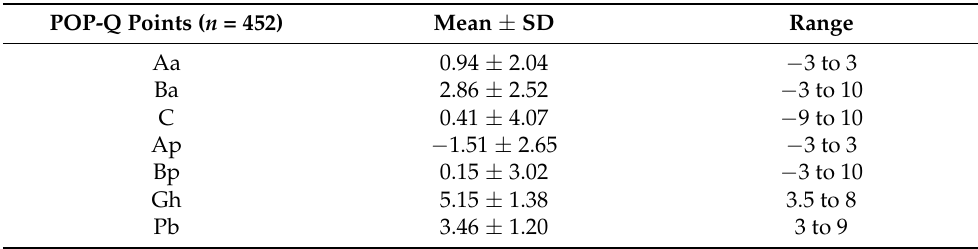
Table 1. Clinical findings of pelvic organ prolapse quantification (POP-Q) of 452 patients with symptoms of pelvic organ prolapse.